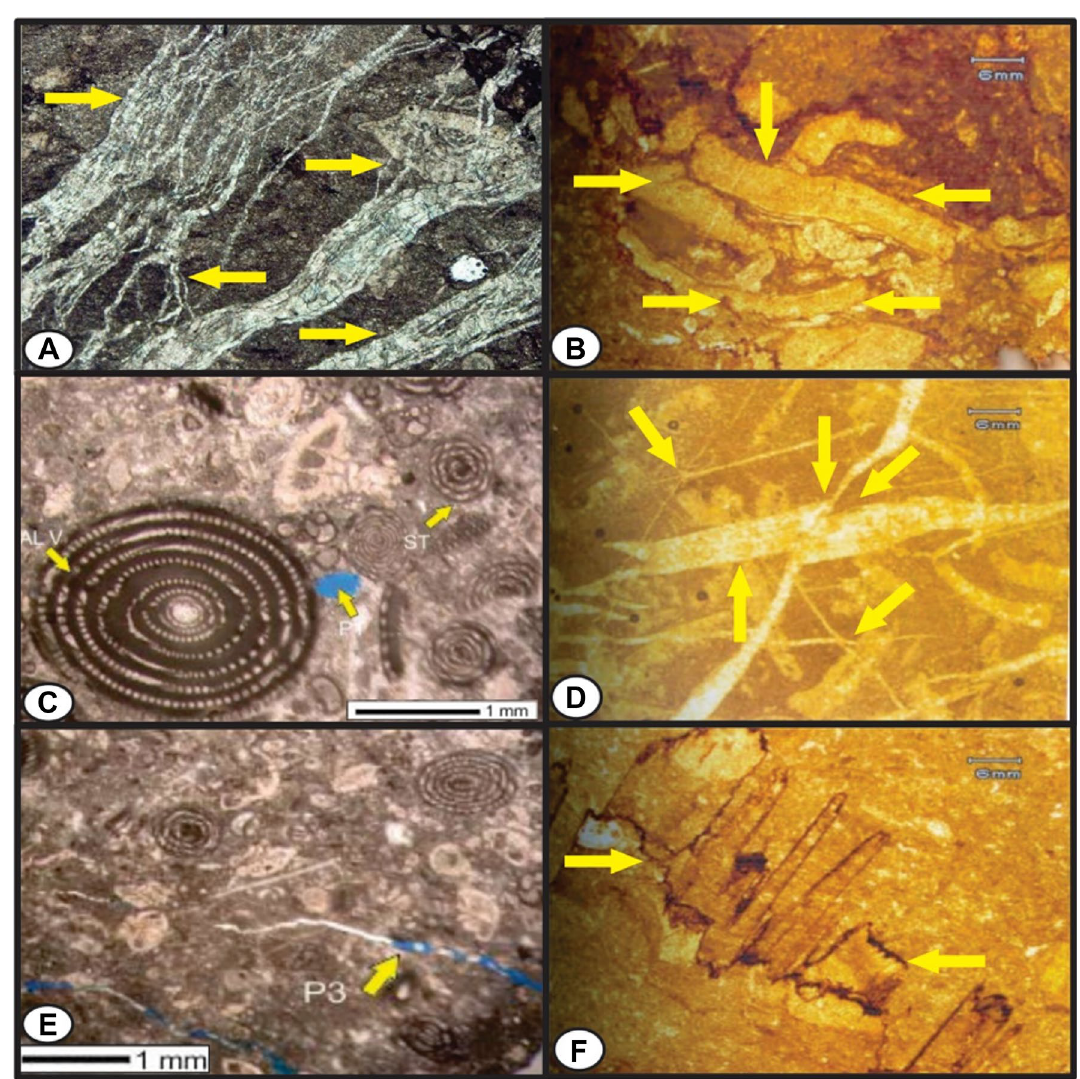
Fig. 15 Photomicrographs of diagenetic features within the carbon- ates of the Lockhart Limestone a Parallel sets of calcite-filled micro- fracture (arrowhead) swarms intersecting Lockhartia sp. (top right). These calcite-filled microfracture swarms seem to be the result of hydraulic fracturing of Lockhart Limestone (Plane polarized light, Mag. × 4) (Ali et al. 2014); b Tight fabric of allochemical constitu- ents, attributed to phenomena of post depositional pressure dissolu-